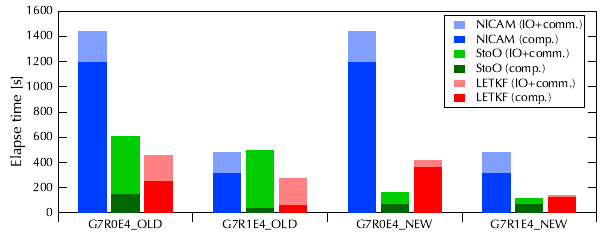
Figure 4. The time taken by NICAM–LETKF on the old and new